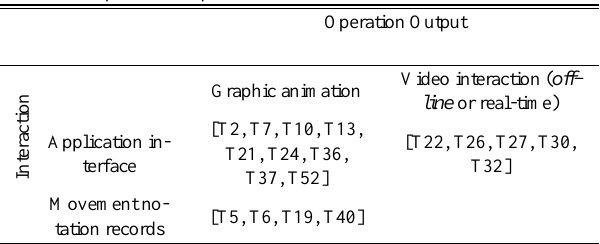
Table 6. Categorization of selected technologies based on interaction and operation output (item 9). Source: The authors. Operation